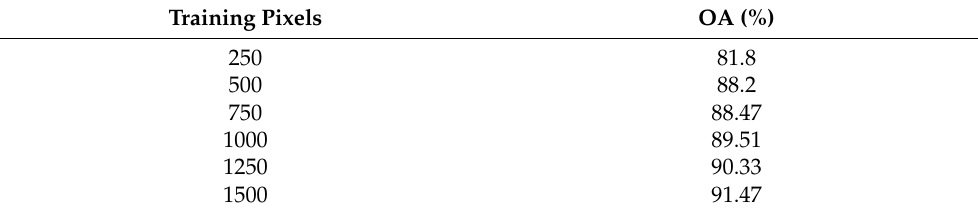
Figure 10. Distribution map of black locust in the Danubian lowland. Table 4. Effect of shrinking the training dataset on classification